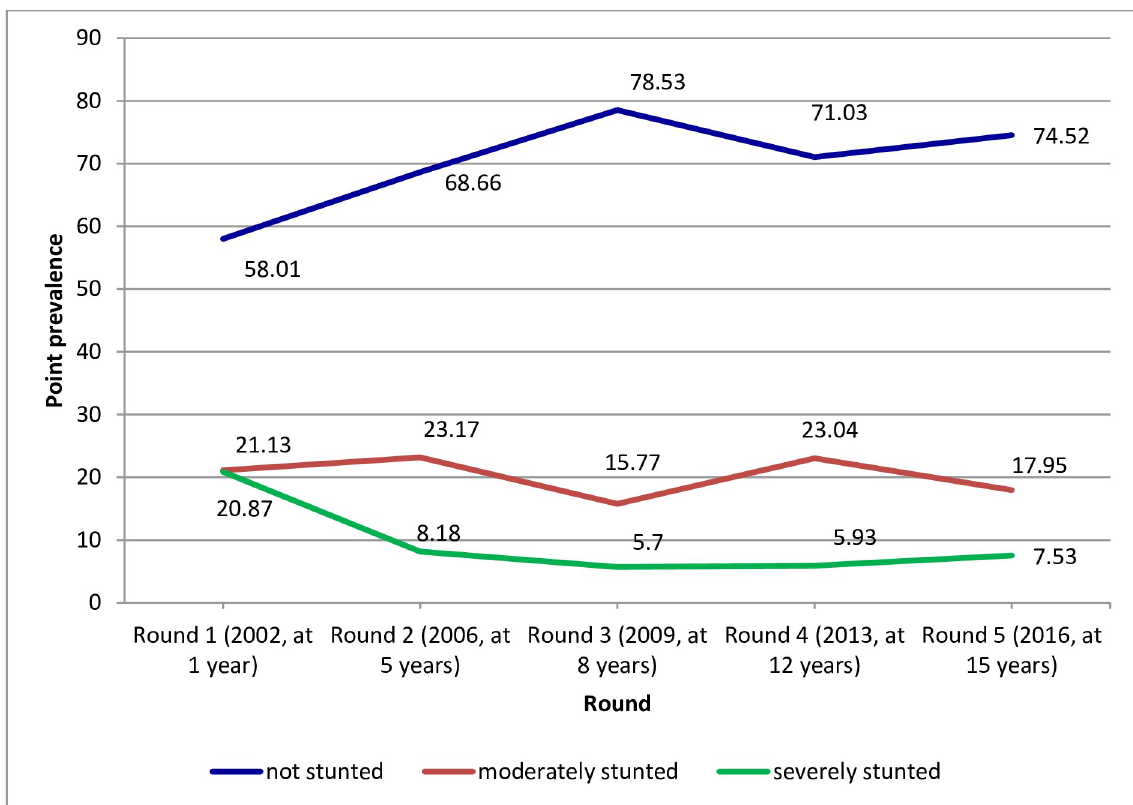
Fig 2. Cross-sectional (point) prevalence of stunting in the younger cohort across the five rounds (childhood to youthhood), Ethiopia,